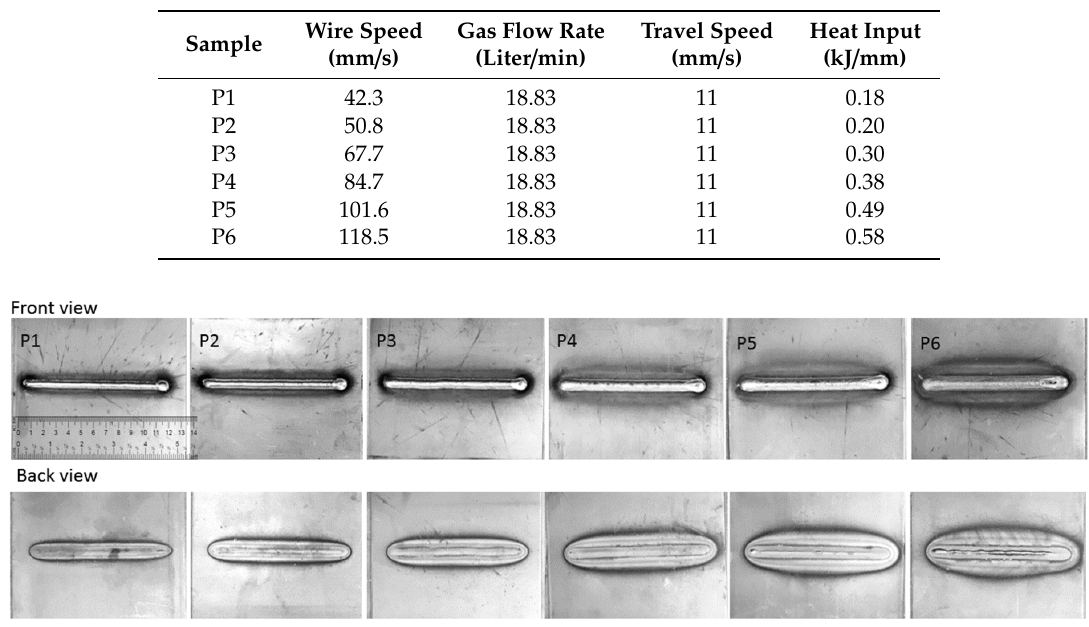
Table 2. The specifications of weld samples.